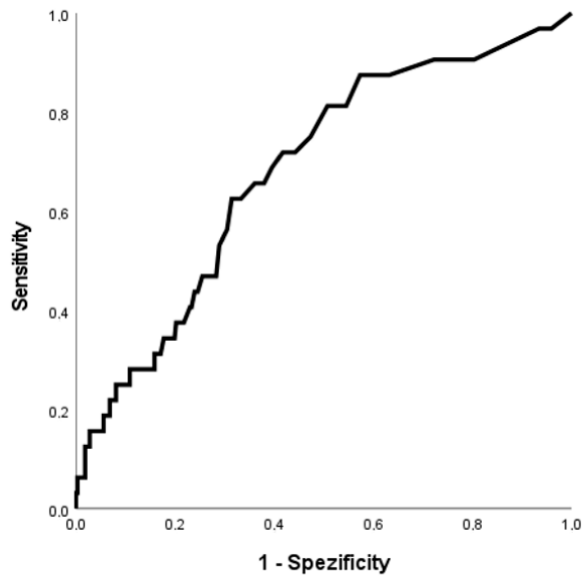
Figure 2. Receiver operating characteristic (ROC) curve showing the discrimination of initial highly sensitive troponin T (hsTnT) for major adverse cardiac events.